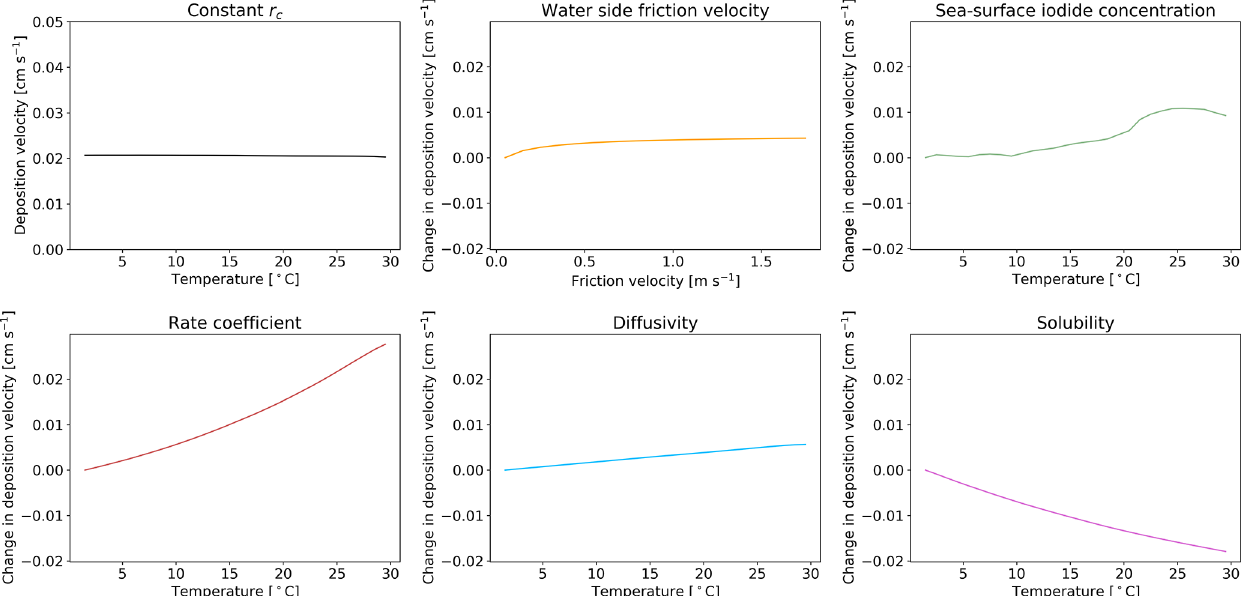
Figure 5. The response of deposition velocity to the variation of only a single parameter, with other parameters set to global average values. Sea-surface iodide concentration [I − ], rate coefficient k , diffusivity D and solubility α are produced from global values averaged into 1K